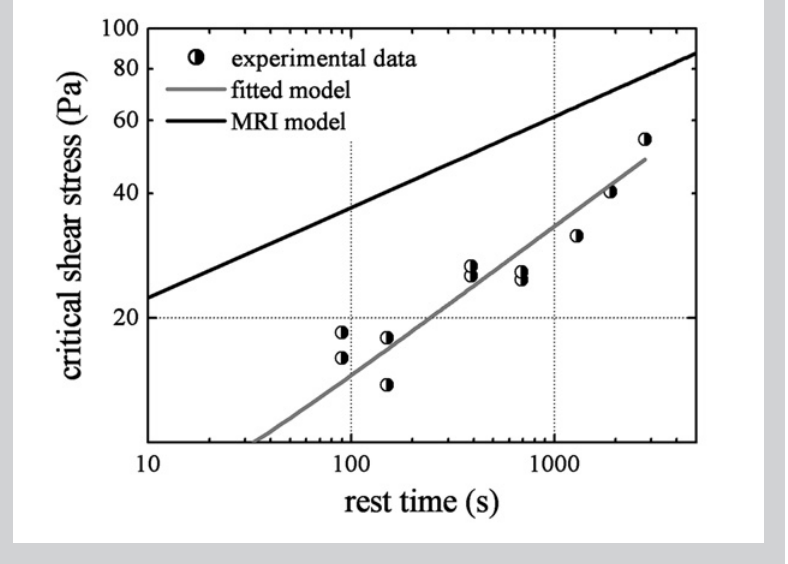
Figure 11: Critical shear stress as a function of the time of rest. Comparison with the predic- tions of the model with parameters values obtained from MRI measurements = 0.269 Pas, [20] (n = 1.22, h 0 q = 0.15 s, and a = 0.203) and with newly fitted para- meters values (n = 1.36, q = 2.39 s, and h / a = 0